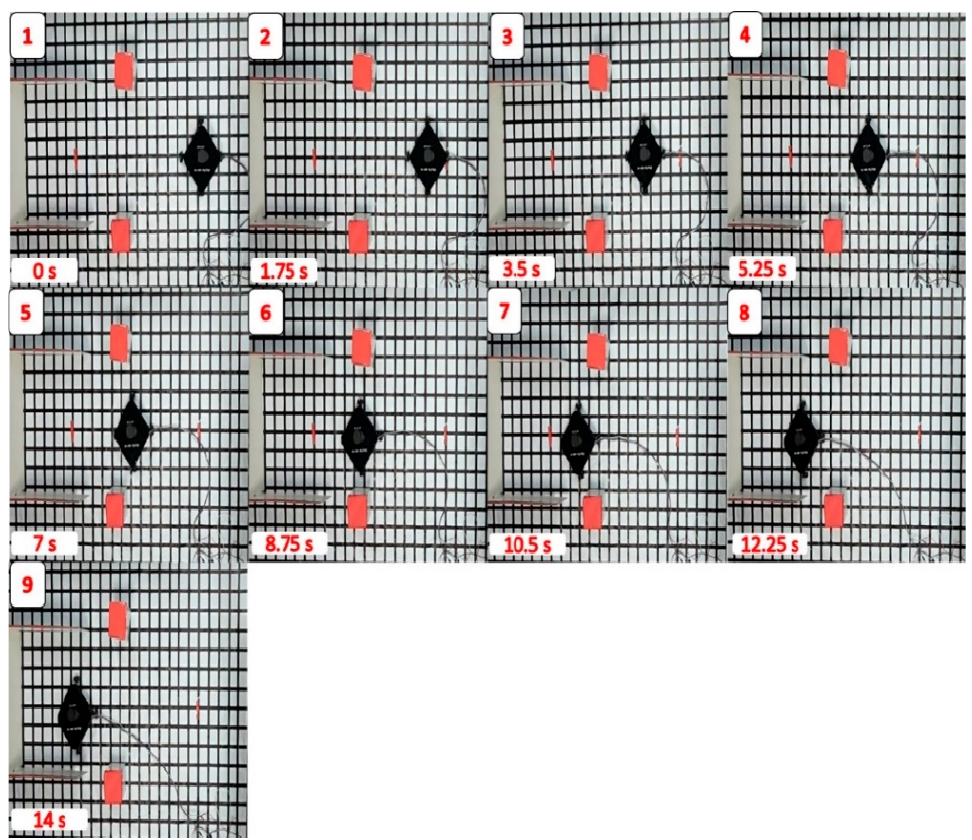
Figure 8. Screenshots for the experimental implementation of the Hybrid A* algorithm on the 4OWMR for Map1.